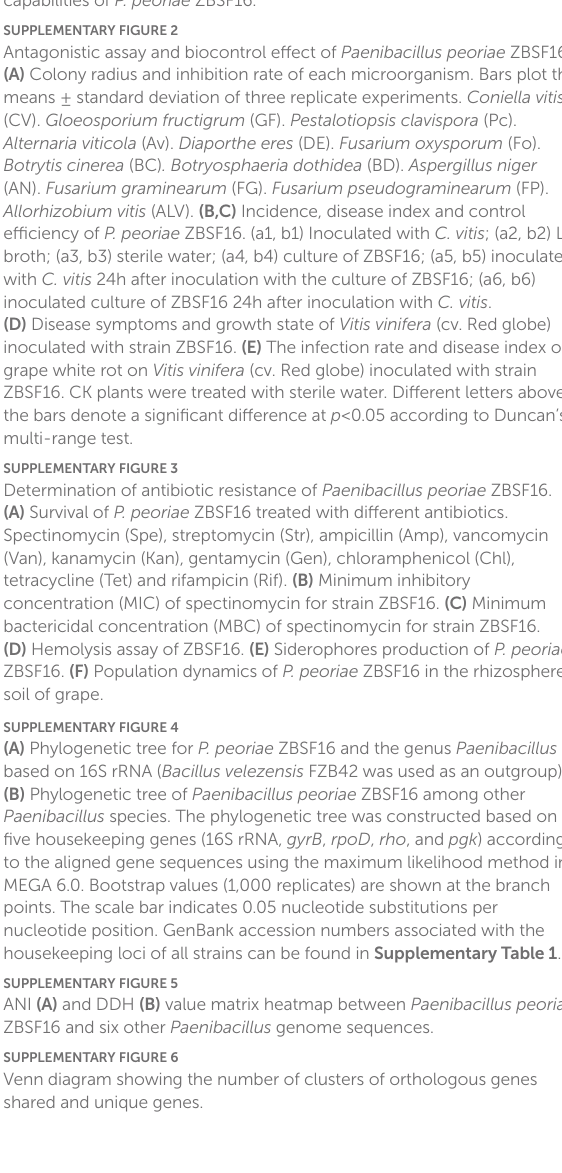
SUPPLEMENTARY FIGURE 1 General characteristics of Paenibacillus peoriae ZBSF16. (A) Image of ZBSF16 colony morphology. (B) Image of ZBSF16 cells via scanning electron microscopy. (C) Growth dynamics and pH change of P. peoriae ZBSF16. Bars plot the means ± standard deviation of three replicate experiments. P (D) Production of protease. (E) Cellulose degradation.